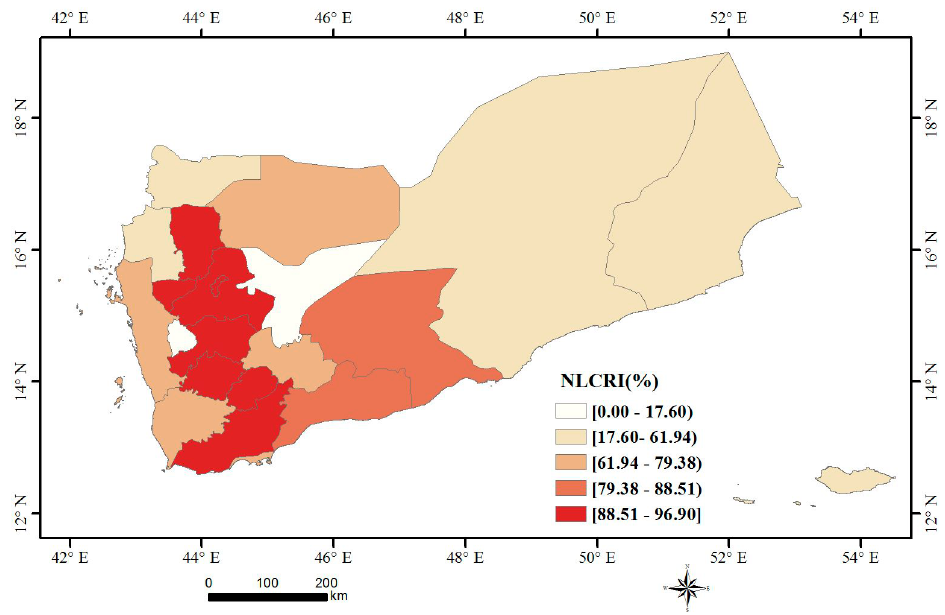
Figure 10. Nighttime light change rate index (NLCRI) for Yemen from February 2015 to June 2015.